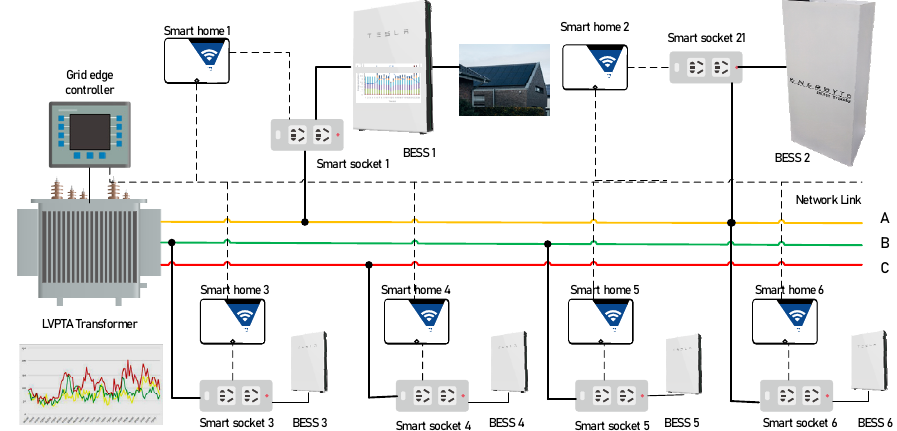
Figure 1. The system structure in LVTPA.